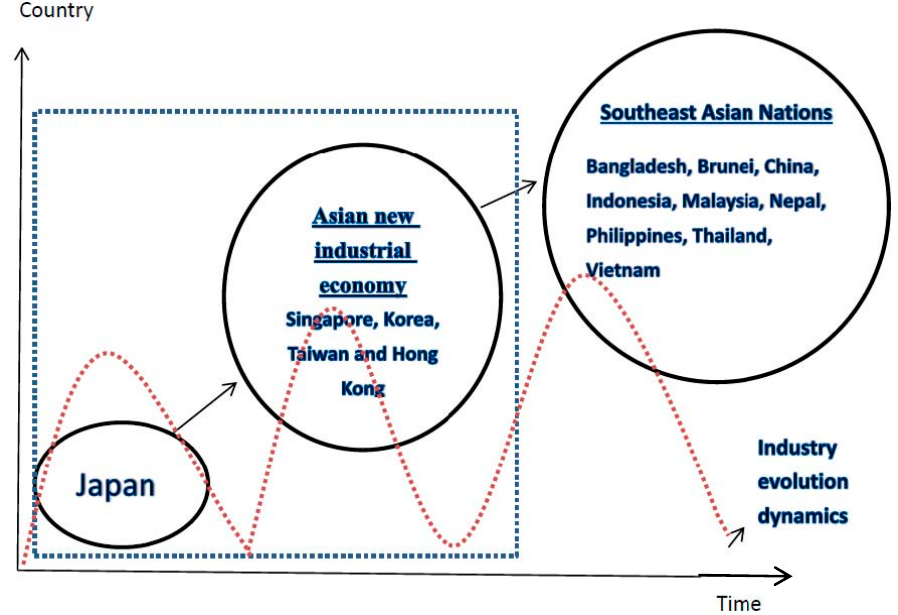
Figure 1. Industry evolution dynamics. Note: As Kyoshi [28] mentioned, we explicitly account for the extent of economic development and divide countries into three groups: first, Japan; then Newly-Industrializing Economies (NIEs) including Korea, Hong Kong, Singapore and Taiwan; second, southeast countries plus China; third, the other regions, mainly Middle Eastern nations, in Asia.